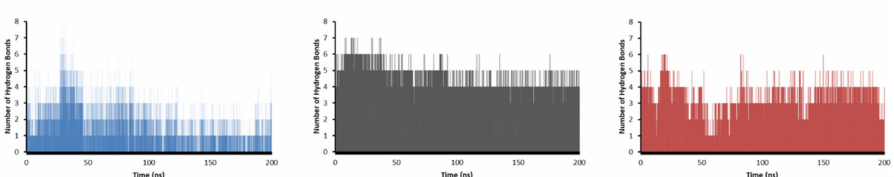
Figure 14. The number of hydrogen bonds for 11c (blue), 11d (gray), and 11e (red) in complex with DprE1 during the 200 ns of